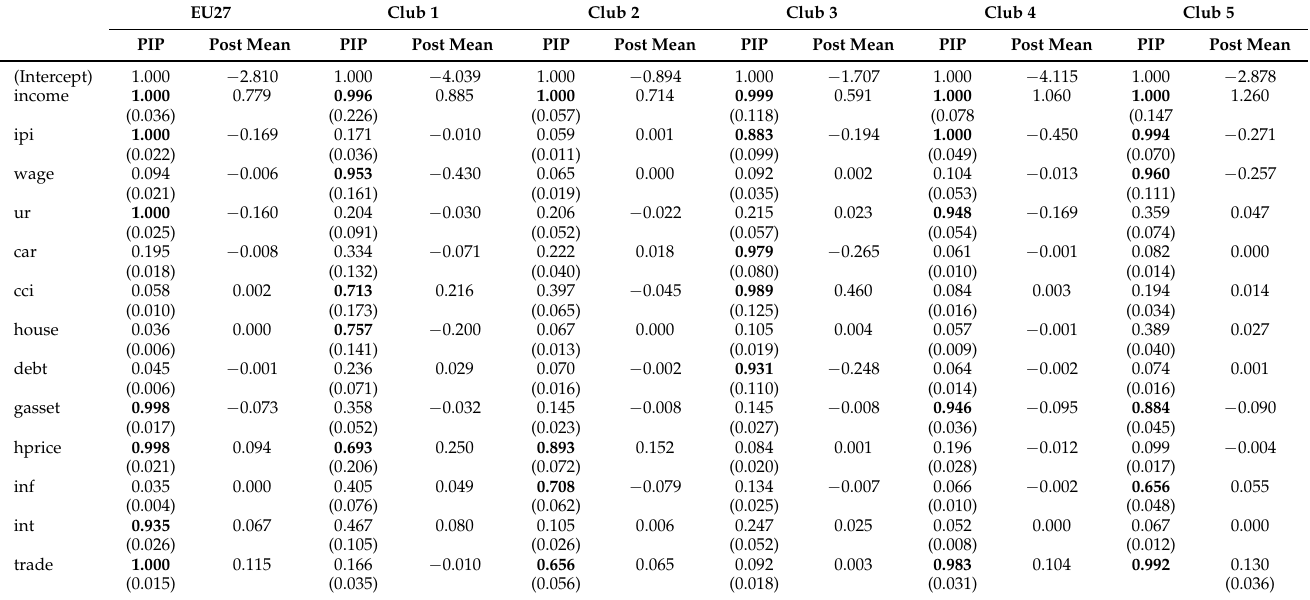
Table 2. BMA results—short-run